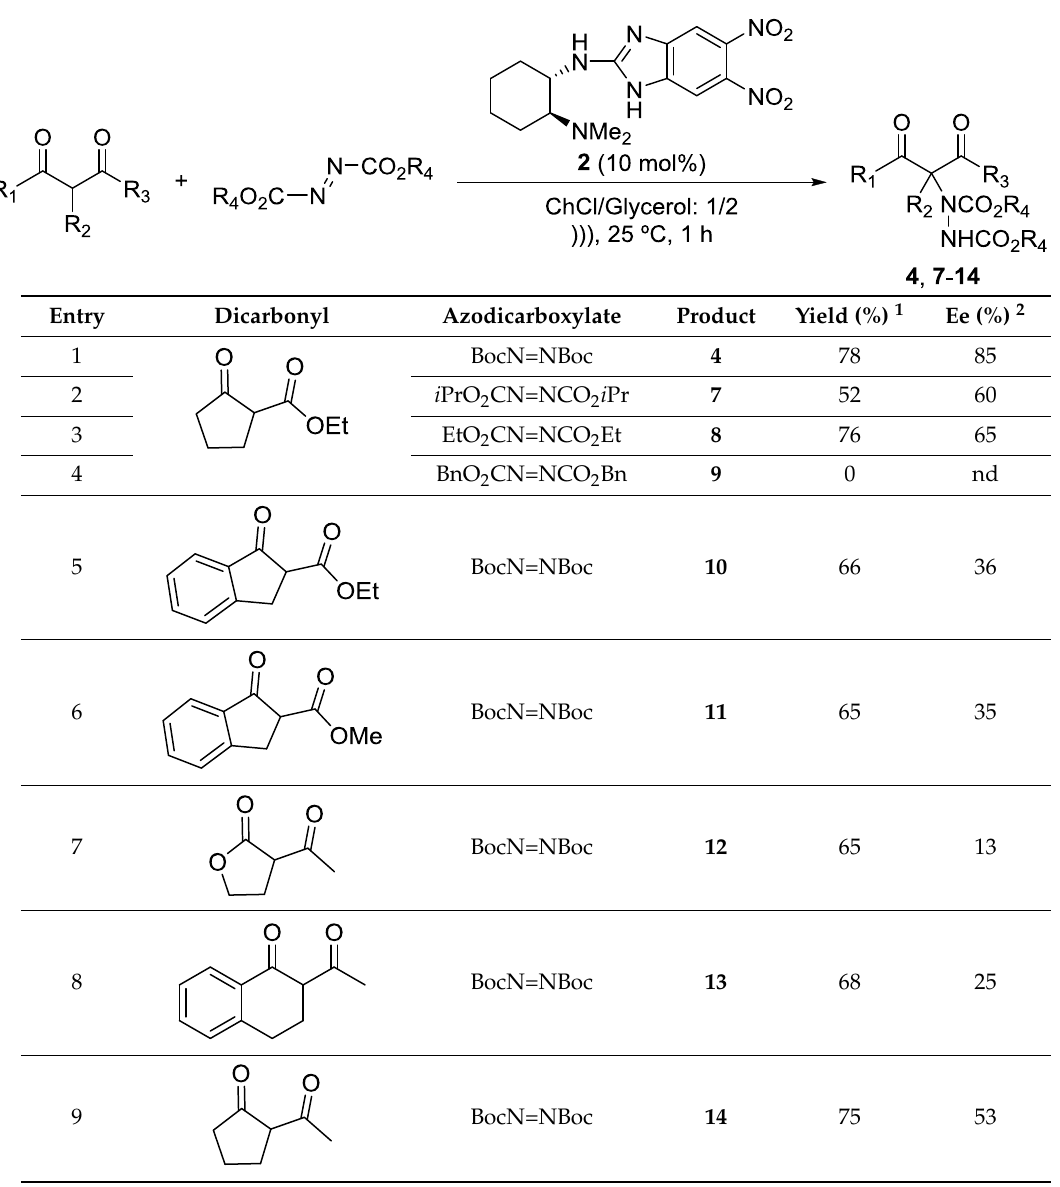
Table 3. Asymmetric α-amination catalyzed by 3 . Reaction scope.